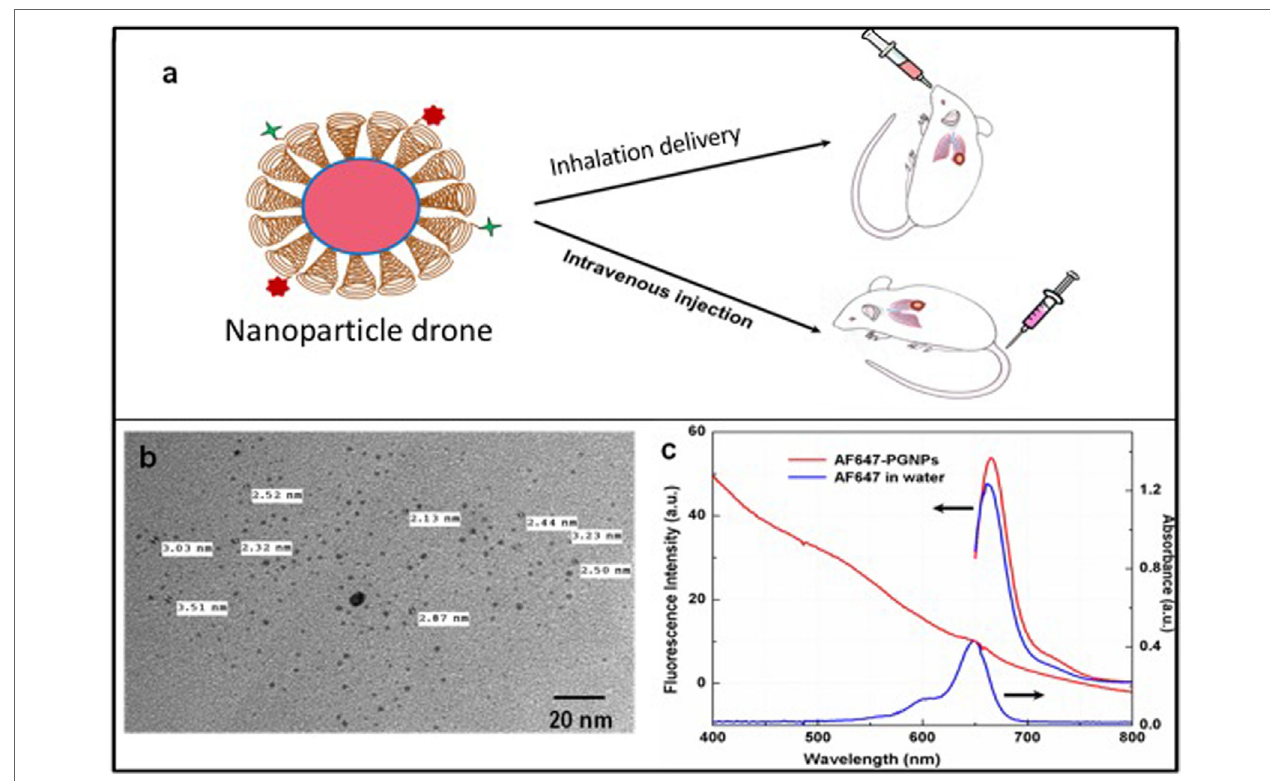
FiGUre 1 | (A) Cartoon showing both intravenous and inhalation (INH) delivery of nanoparticle drones; (B) TEM image of lung tumor targeted with drones; (c) absorption spectra of drone technology uniquely customized for INH delivery to lung